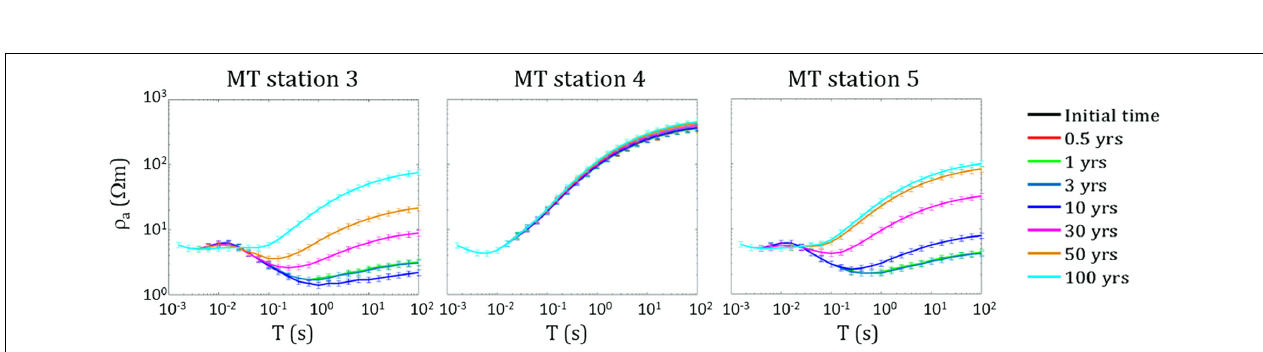
FIGURE 7 | Scenario I. (A) Ratio between the synthetic apparent resistivity values ( ρ a ) and the initial resistivity value ( ρ ai ) estimated for the three central MT stations as a function of time at the fixed period T = 1 s. (B) Ratio between the synthetic apparent resistivity values ( ρ a ) and the initial resistivity value ( ρ ai ) estimated after a simulation time of 100 years for the seven MT stations at three fixed periods.